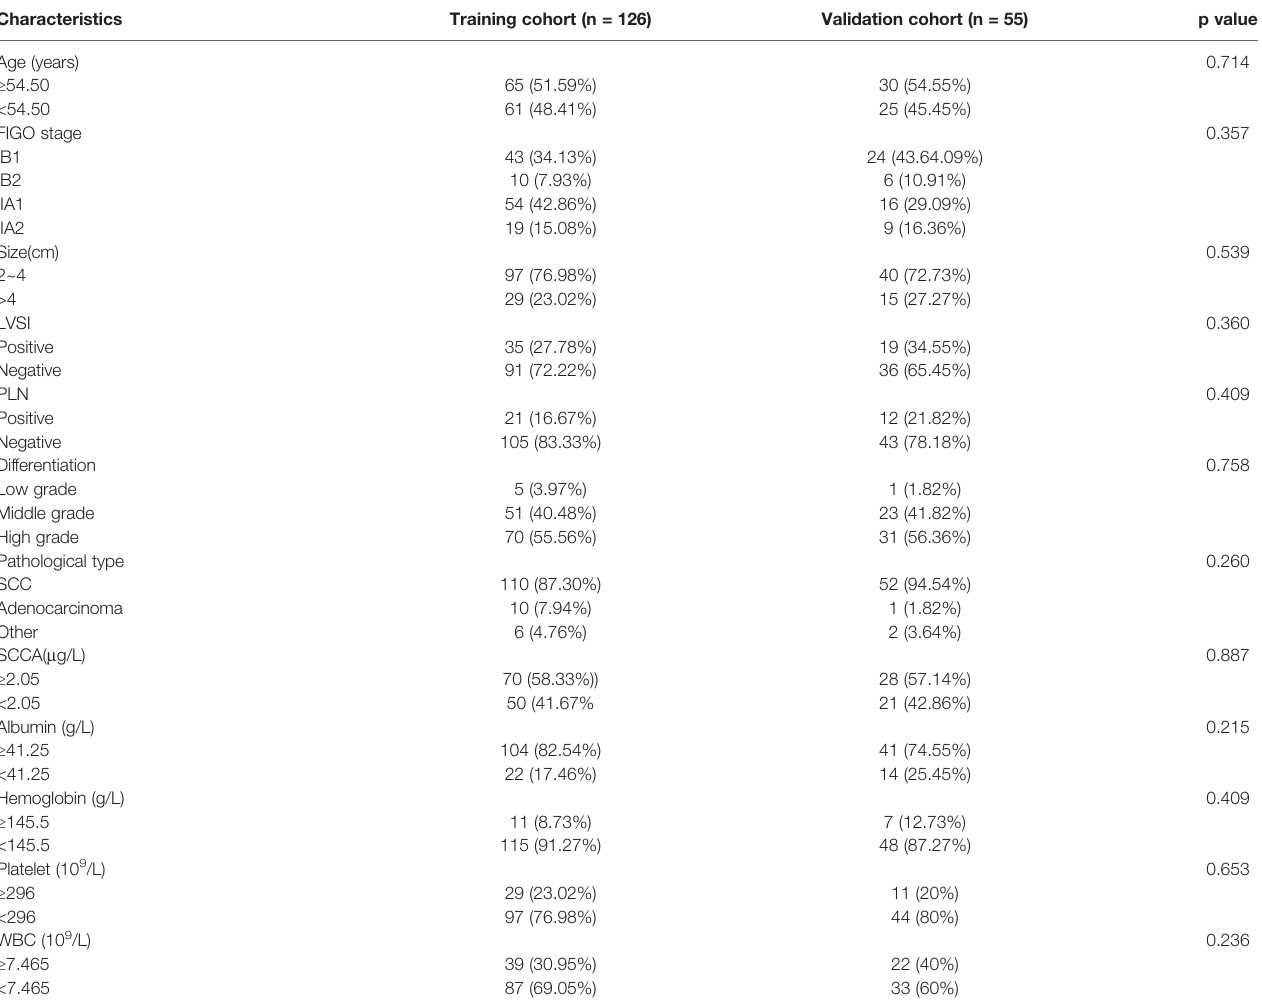
FIGO, International Federation of Gynecology and Obstetrics; LVSI, lymph vascular space invasion; LNM, lymph node metastasis; SCC, squamous cell carcinoma; SCCA, squamous cell carcinoma antigen; WBC, white blood cell.